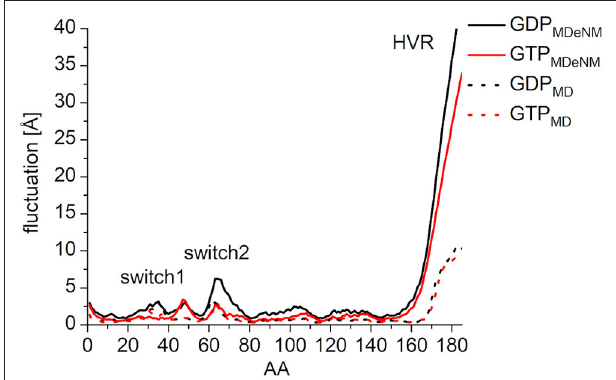
FIGURE 7 | RMS fluctuation of C α atoms among the MDeNM (solid) and MD (dotted) generated conformations for GDP- (black) and GTP-bound (red)